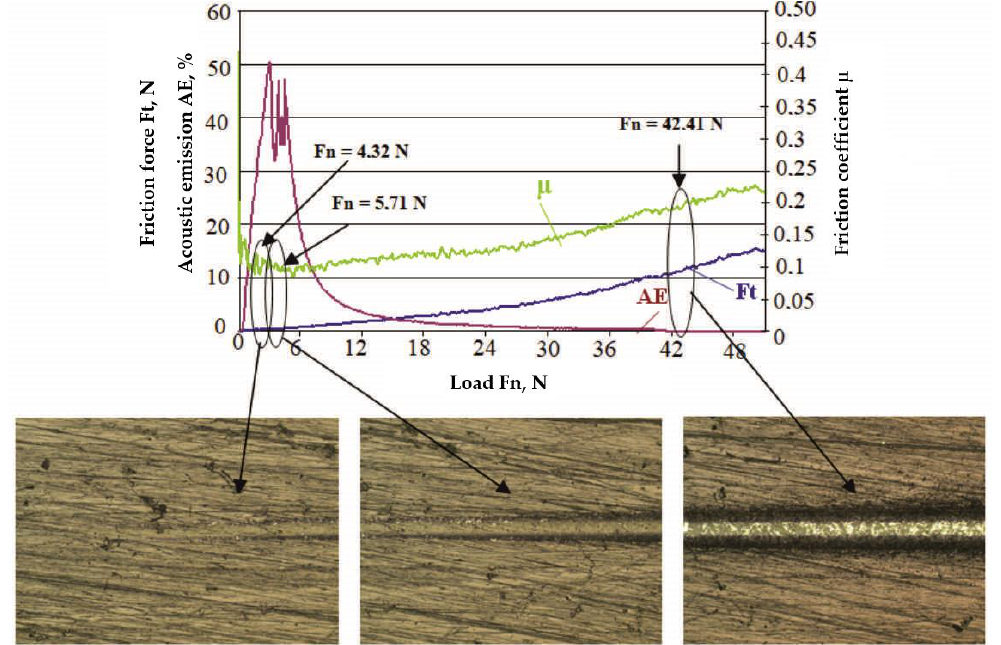
Figure 2. Adhesion of the carbon layer deposited by radio frequency plasma activated chemical vapor deposition (RF PACVD) on the X39Cr13 substrate.